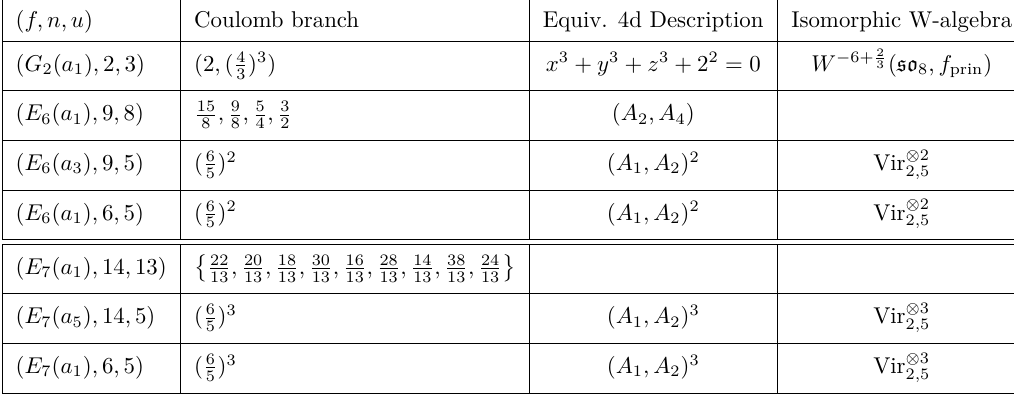
Table 21 . The dimensions of Coulomb branch operators, equivalent 4d descriptions and possible ismorphic VOAs of 4d theories whose 2d VOA is W − h ∨ + n obtained by matching Coulomb branch operators and central